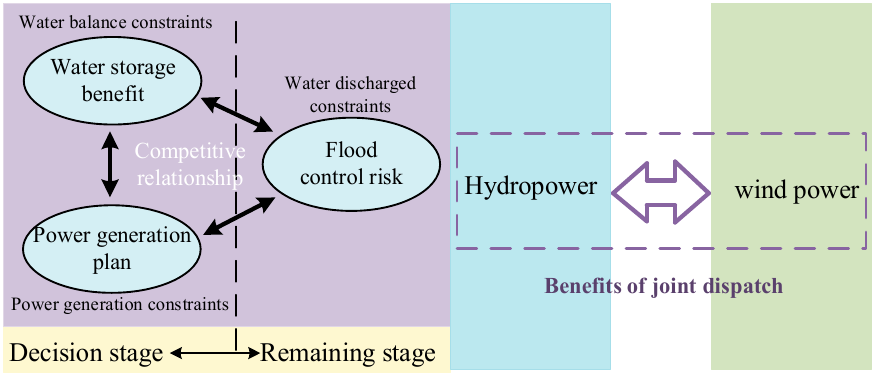
Figure 2. Multi-objective hedging relationship in the joint dispatch of hydropower and wind power. In summary, it can be seen that the joint dispatch of hydropower and wind power is a complex multi-objective conflict problem, which can be analyzed by hedging theory. According to the two-stage model of risk hedging described in Section 2.2, the essence of the two-stage model is to “take out” the benefits of water supply in the future stage to achieve the reduction risk of water supply benefits brought about by the priority water supply in the current stage. Additionally, there is a timing correlation between the two scheduling stages. This model method has obtained good application effects in the dispatching of a single water supply reservoir and a group of water supply reservoirs. Based on the implicit timing relationship between the hydropower station and the downstream